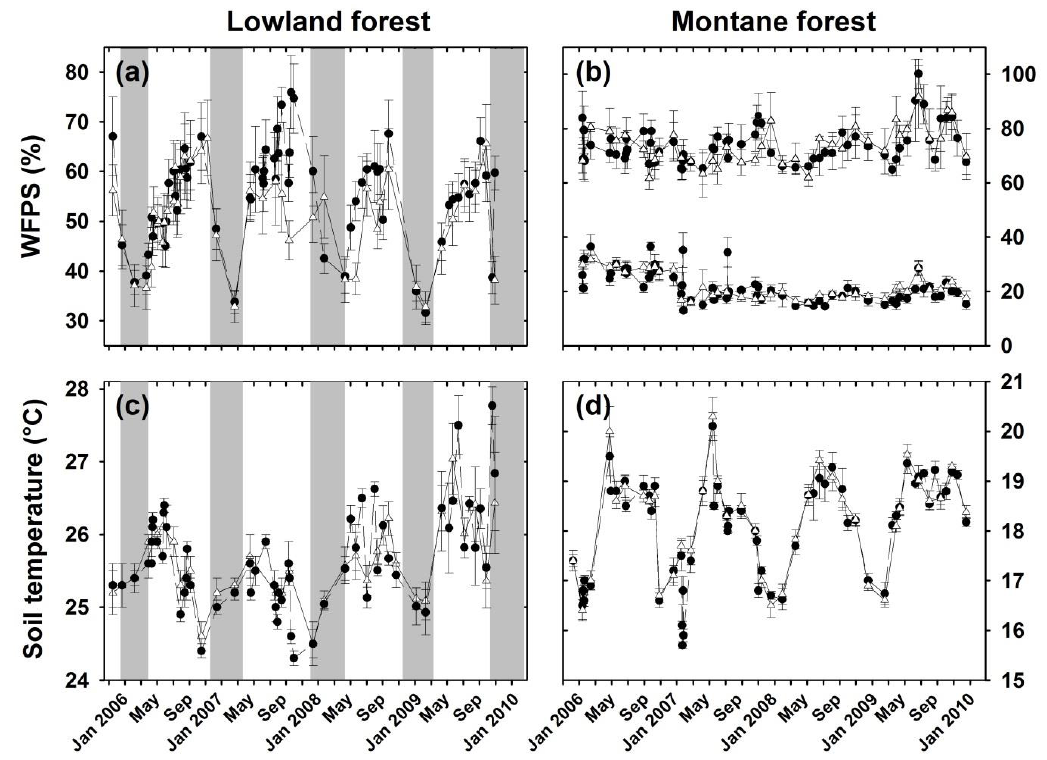
Fig. 1. Mean ( ± SE, n = 4) soil water-filled pore space (WFPS) and temperature at 0–0.05m mineral soil in the control ( 4 ) and N-addition ( • ) plots of the lowland forest ( a and c ) with 9–12yr of treatment and of the montane forest ( b and d ) with 1–4yr of treatment. For WFPS in the montane forest, the upper and lower values are for the 0–0.05m mineral soil and organic layer, respectively. Grey shadings in (a) and (c) mark the dry seasons. The first two years were previously reported by Koehler et al.